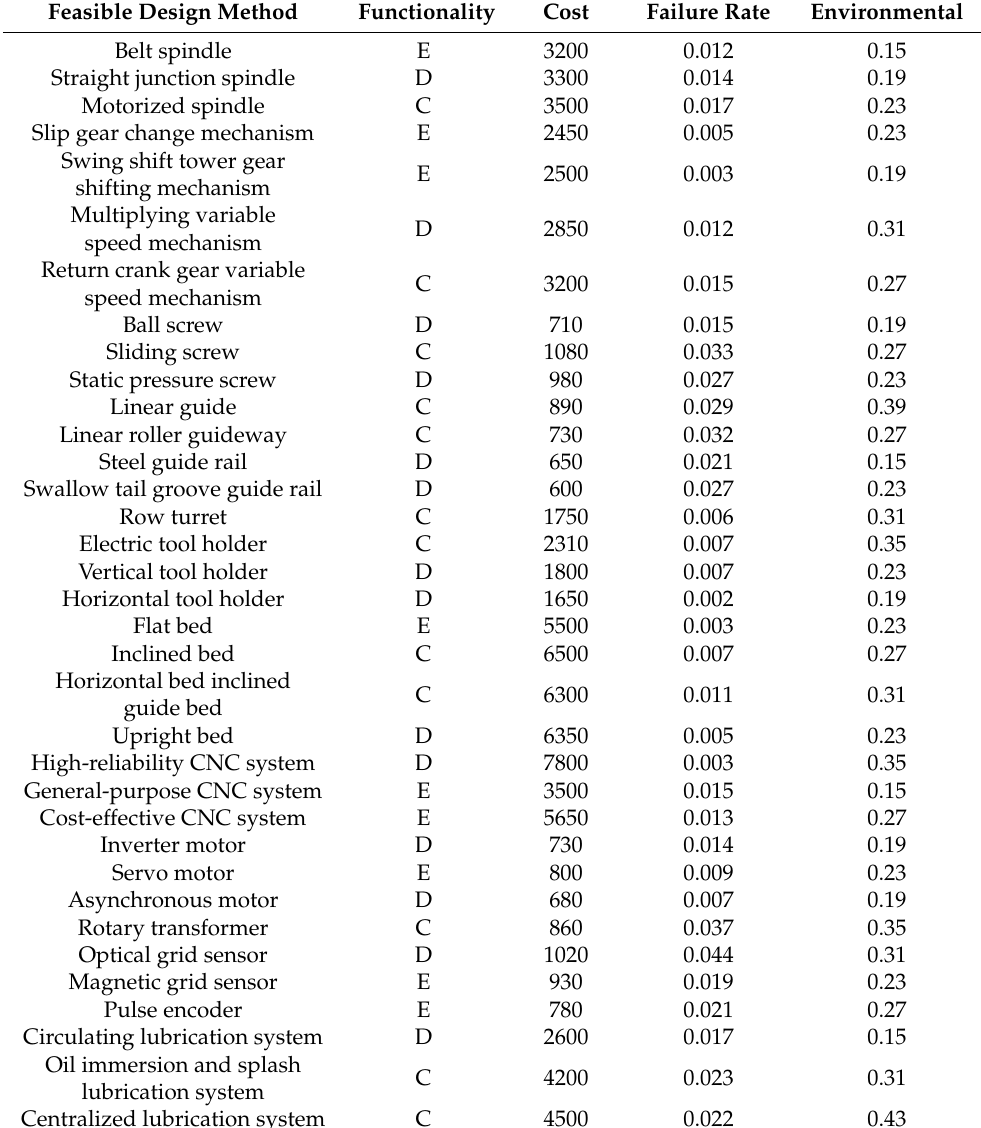
Table 12. Comprehensive data table of feasible design